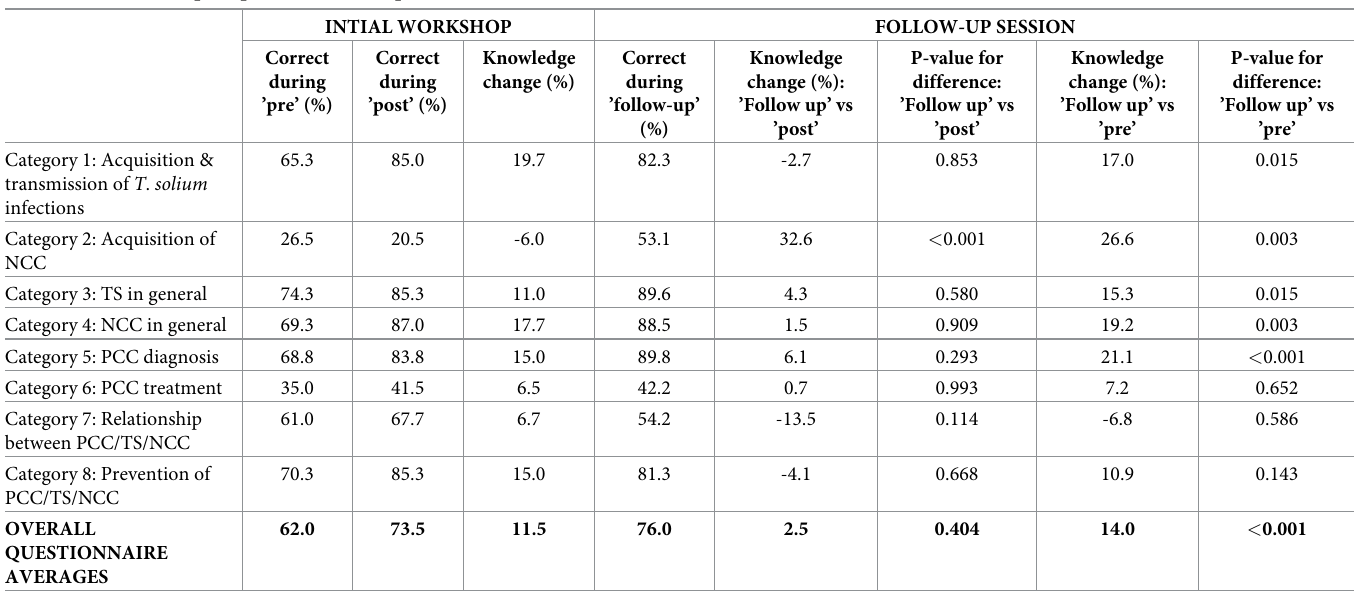
Table 1. Results from ‘pre’, ‘post’ and ‘follow-up’ assessments